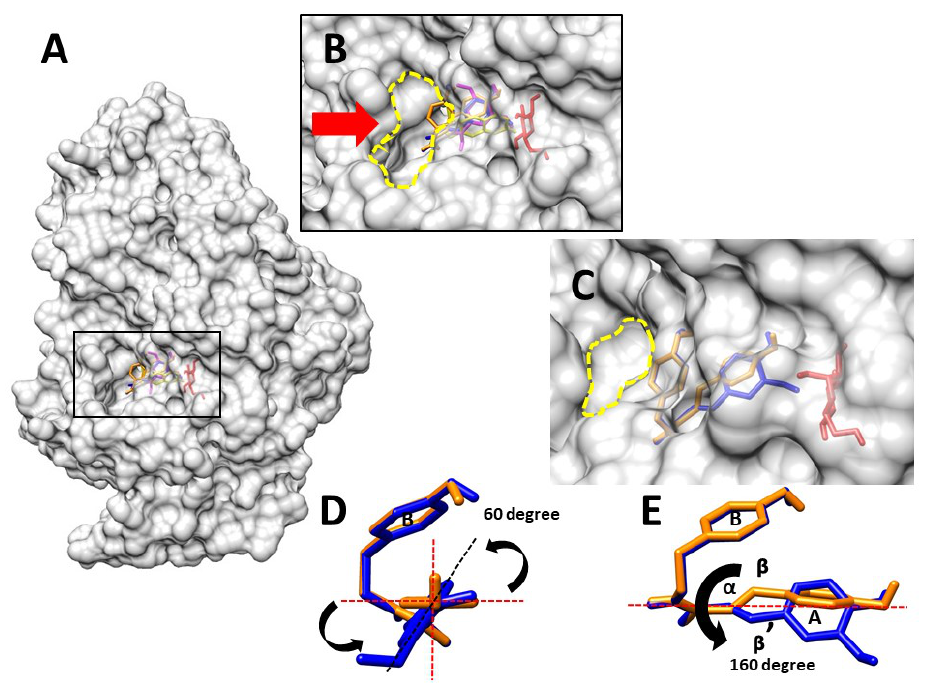
Figure 5. The molecular interaction between the alpha-glucosidase, presented in grey color and glucose as in red color, 1 as in yellow color, 2 as in pink color, 4 in blue color and 5 as in orange color, respectively. ( A ) The molecular interaction between the alpha-glucosidase and the mentioned. ( B ) The expanded picture at the active site of the alpha-glucosidase. The dashed circle in yellow color indicated the entrance gate to the active site, while the red arrow was used to emphasis this gate. ( C ) The comparison between the docked conformations of 4 in blue color and 5 as in orange color at the entrance gate of the active site. ( D , E ) The alteration of the docked conformation between 4 as in blue color and 5 as in orange color. The red dashed lines indicated the X and Y-axis, while the black arrows indicated the changing of the position in the chemical